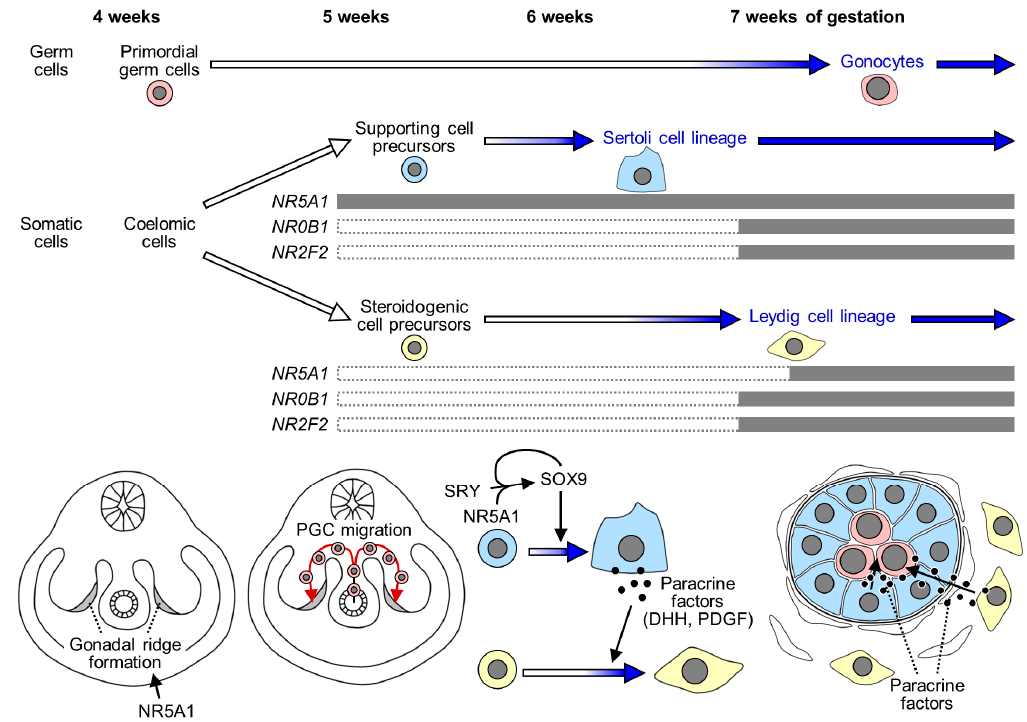
Figure 1. Gonadal differentiation in males. Cells written in blue letters are sexually differentiated (male). Thick arrows depict cell differentiation. Gray boxes indicate gene expression in the cells. Dotted boxes indicate that it is unclear whether the gene is expressed. Gene expression data are based on those published previously [23–27]. Thin black arrows indicate the action of molecules, and thin red arrows depict cell migration. DHH, desert hedgehog; NR0B1 , nuclear receptor subfamily 0 group B member 1; NR2F2 , nuclear receptor subfamily 2 group F member 2; NR5A1 , nuclear receptor subfamily 5 group A member 1; PDGF, platelet-derived growth factor; PGC, primordial germ cell; SOX9, sex-determining region Y-box 9; SRY, sex-determining region